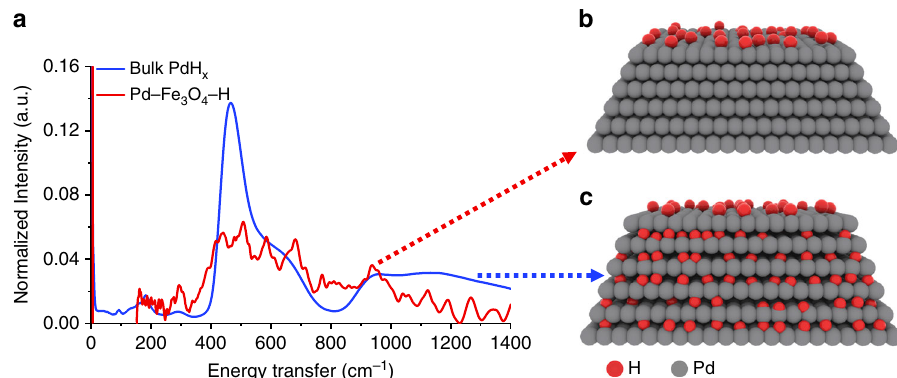
Fig. 6 Determination of reaction intermediate species over Pd – Fe 3 O 4 – H and bulk PdH x . a INS spectra of Pd – Fe 3 O 4 – H and bulk PdH x ; b schematic diagram of surface-H formed in Pd – Fe 3 O 4 – H; and c schematic diagram of hydride formed in bulk PdH x . Source data are provided as a Source data fi